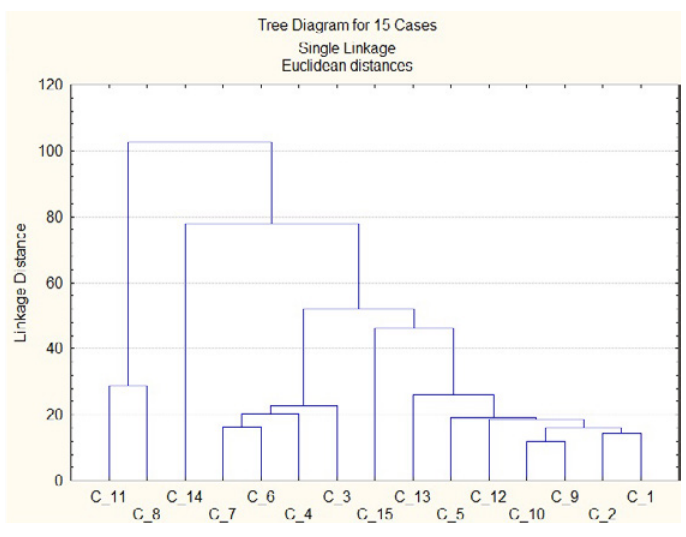
Fig. 4: Dendrogram of building energy efficiency calibration by annual specific energy consumption